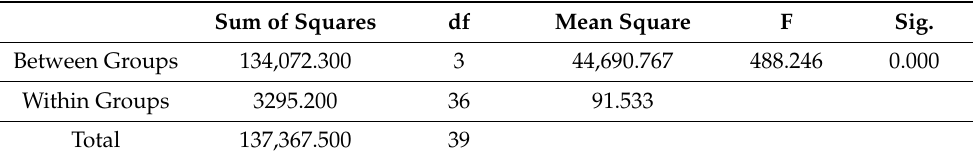
Table 3. One-way ANOVA analysis of the C. albicans viable count. Sum of Squares